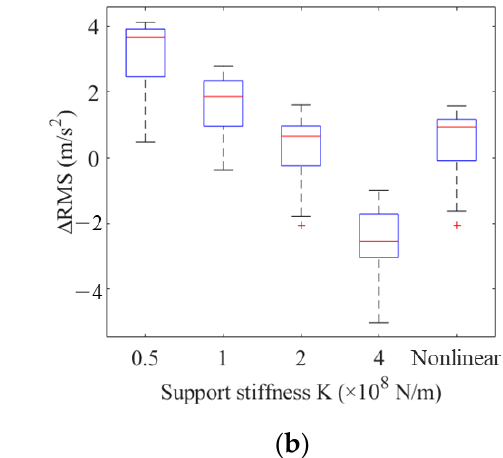
Table 2. Support stiffness parameters of the simulation model.